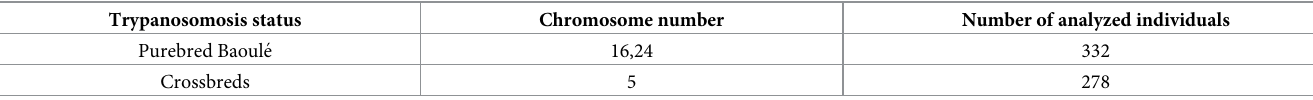
Table 7. Chromosomes with significant effects for trypanosomosis status.